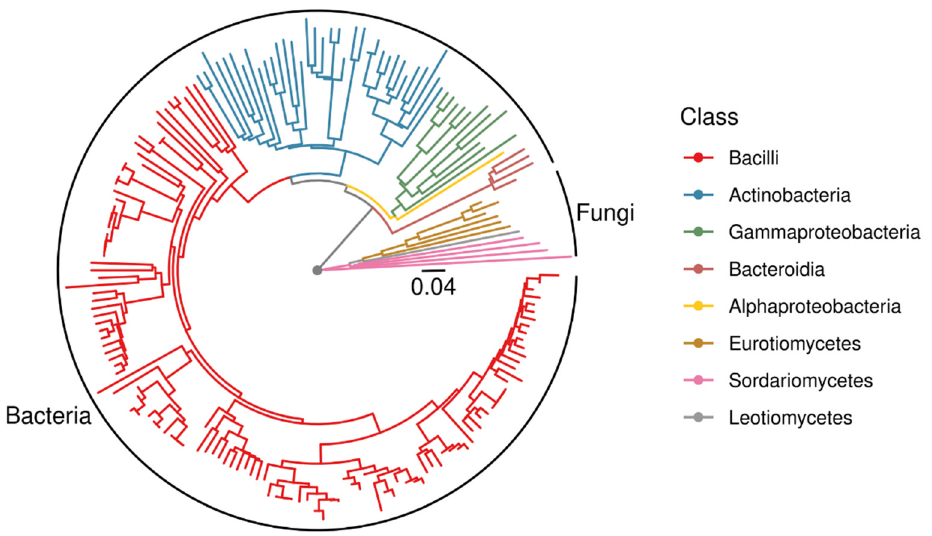
Figure 3. Midpoint-rooted phylogenetic tree of all isolates based on 16S rDNA and ITS sequences.